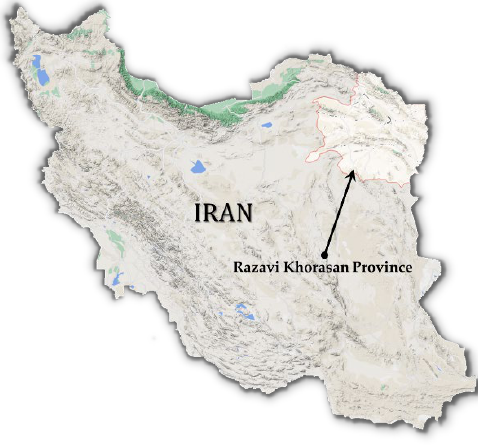
Figure 4. The case study location.